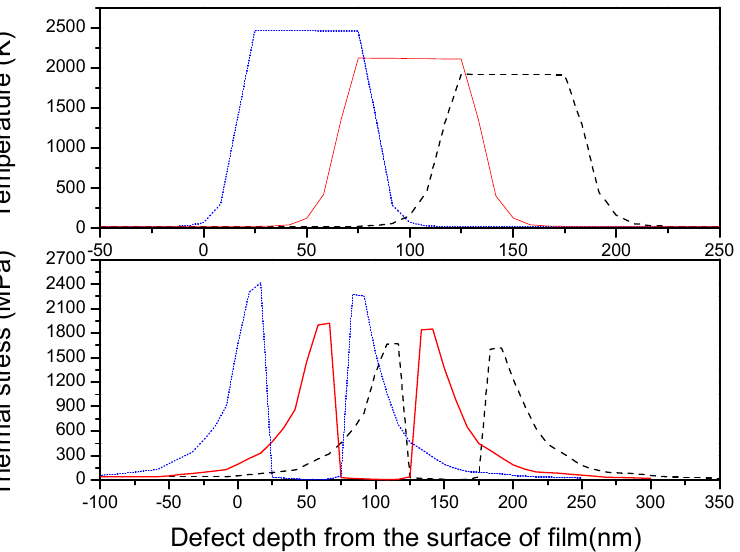
Figure 7. Temperature rise and thermal stress around a defect with the depth from the surface of film of 50 nm (blue line), 100 nm (red line), and 150 nm (black line), respectively.